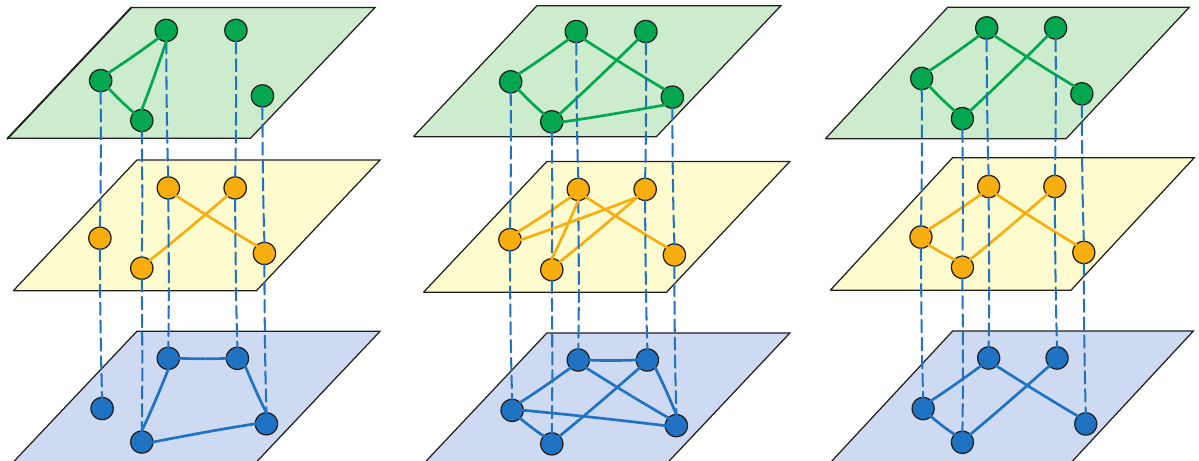
Figure 2: Linkage coefficients corresponding to different network structures.